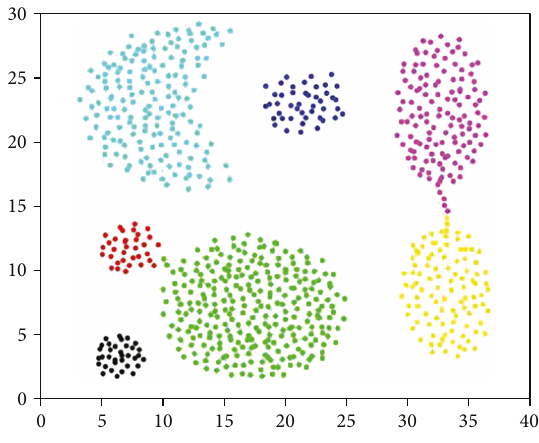
Figure 14: The distribution of